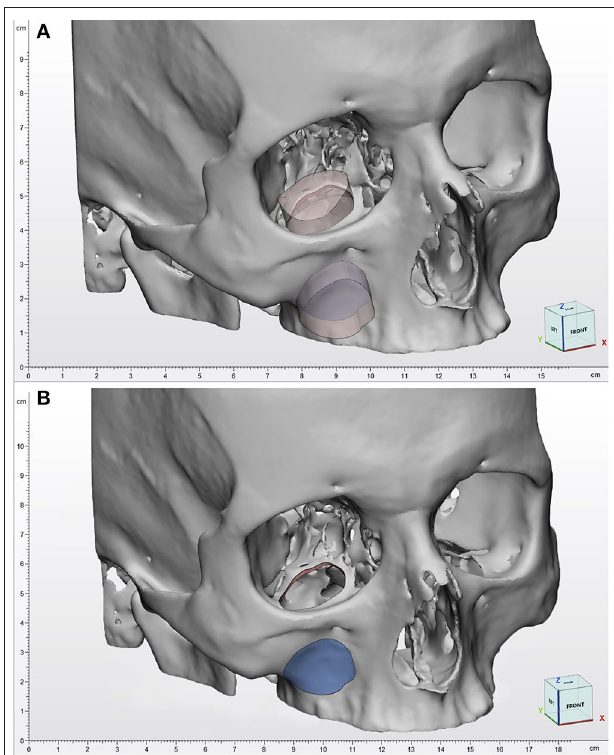
FIGURE 3 | Virtual surgical planning. (A) The transmaxillary and the transorbital portal are defined from a single geometrical template and are therefore correlated. (B) As a consequence, the orbital osteotomy template is used as a reference to design the maxillary wall osteotomy, to facilitate orbital floor reconstruction using an antral wall